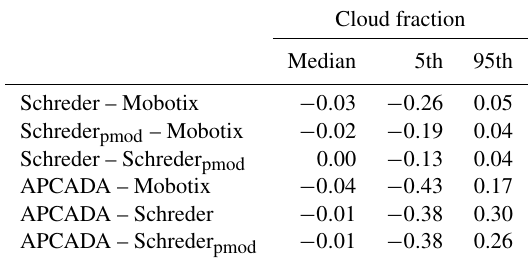
Table 1. Median and 5th and 95th percentiles of the differences in calculated cloud fractions from the visible all-sky cameras and APCADA. The numbers are in the range